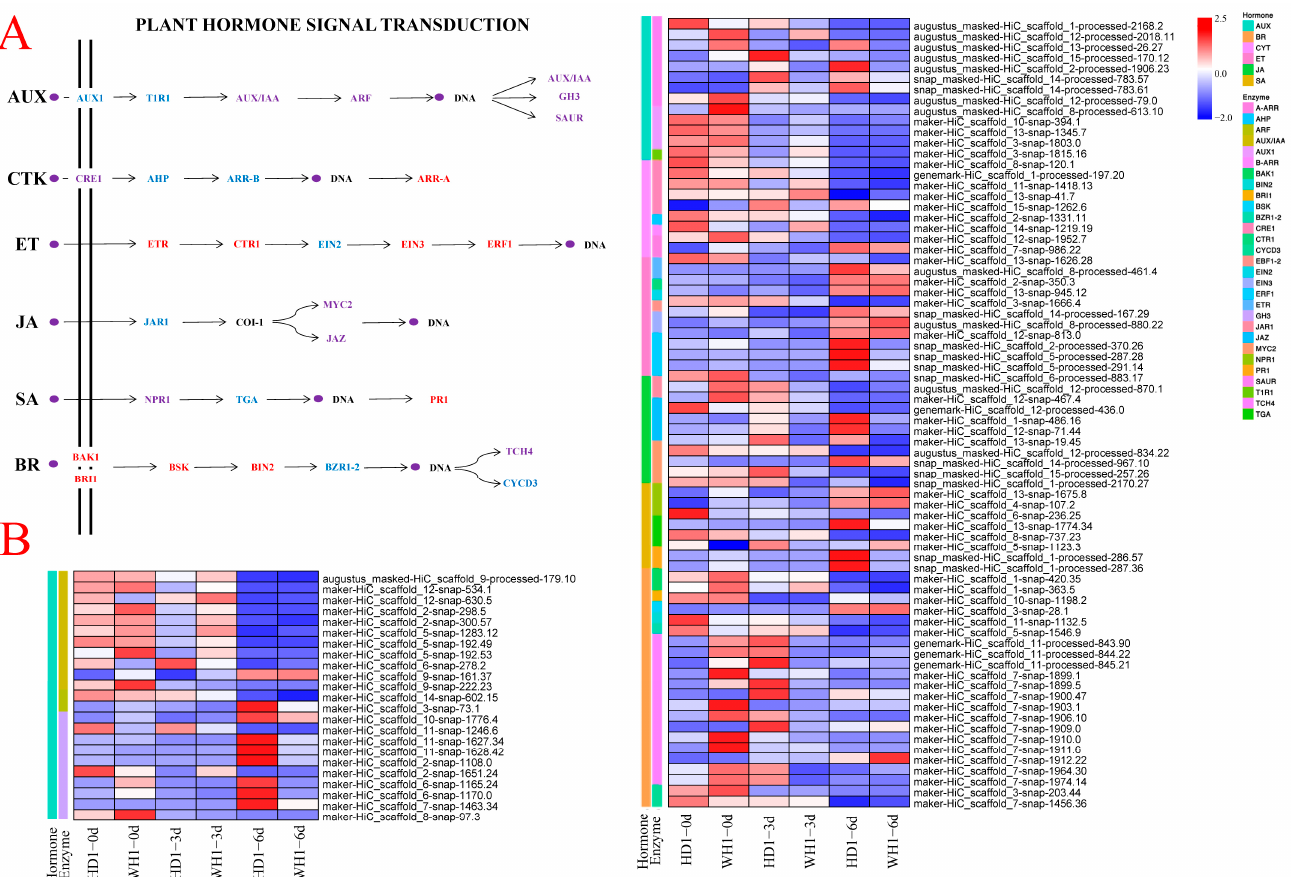
Figure 8. Expression analysis of DEGs enriched in the plant-hormone signal transduction pathway. ( A ): DEGs enriched in the plant-hormone signal transduction pathway in C. vietnamensis leaves. AUX, auxin signal; CTK, cytokinin signal; ET, ethylene signal; JA, jasmonic acid signal; SA, salicylic acid; BR, brassinosteroid signal. Genes in red or blue refer to up- or downregulation responding to drought, respectively. Genes in purple refer to both up- and downregulation in response to drought. ( B ): Heatmap of plant-hormone signal transduction-related gene expression. Values are the average FPKM value of each sample in each group.